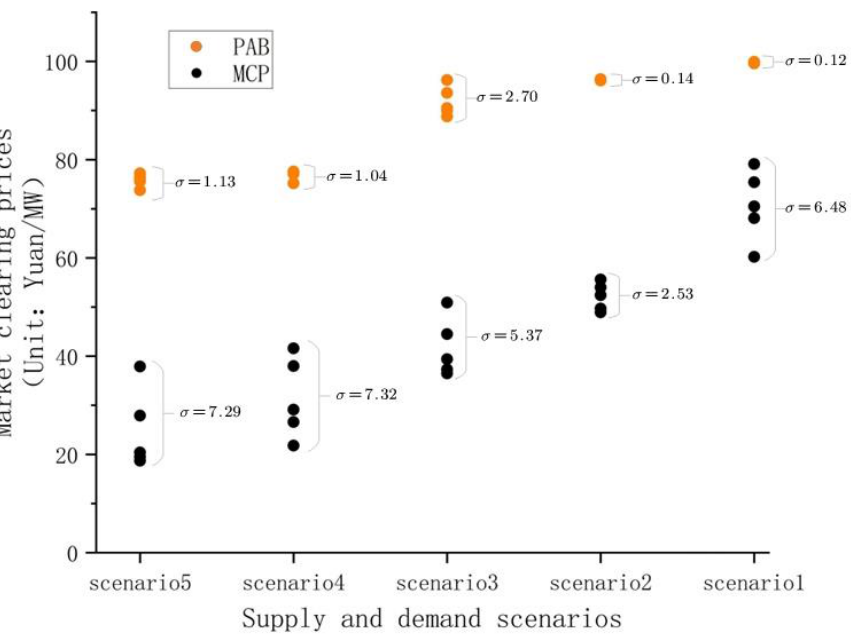
Figure 9. Settlement price distribution in Sichuan when two different pricing mechanisms are adopted, respectively.